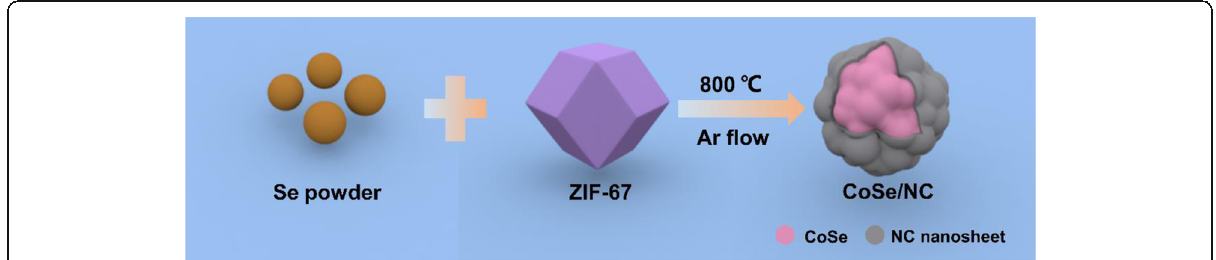
Fig. 1 Schematic diagram for the synthesis of CoSe/NC